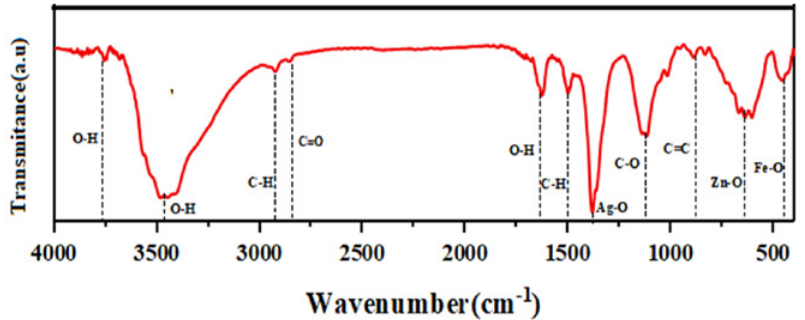
O /ZnO/Ag nanoparticle 3 4